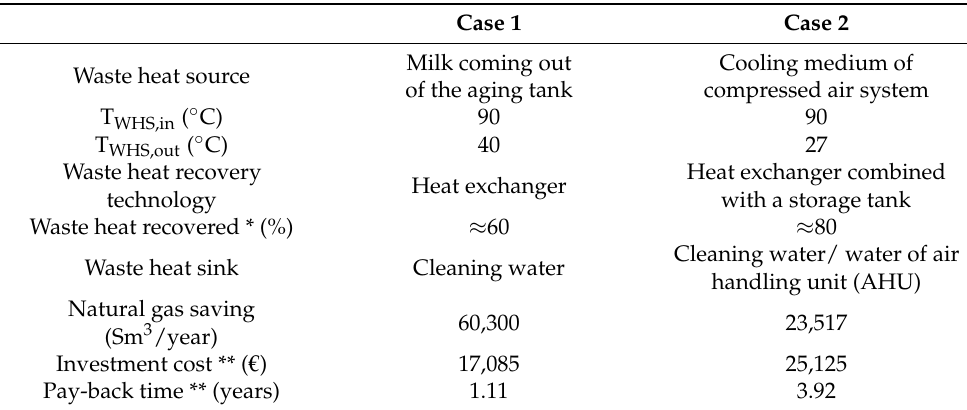
Table 7. Energy and economic performances of two waste heat recovery projects envisaged by an Italian dairy industry that applied the methodology here proposed to map the availability of waste heat sources within its facility. Case 1 Case 2 Milk coming out Cooling medium of Waste heat source of the aging tank compressed air system T WHS,in ( ◦ C) 90 90 Waste heat recovery Heat technology